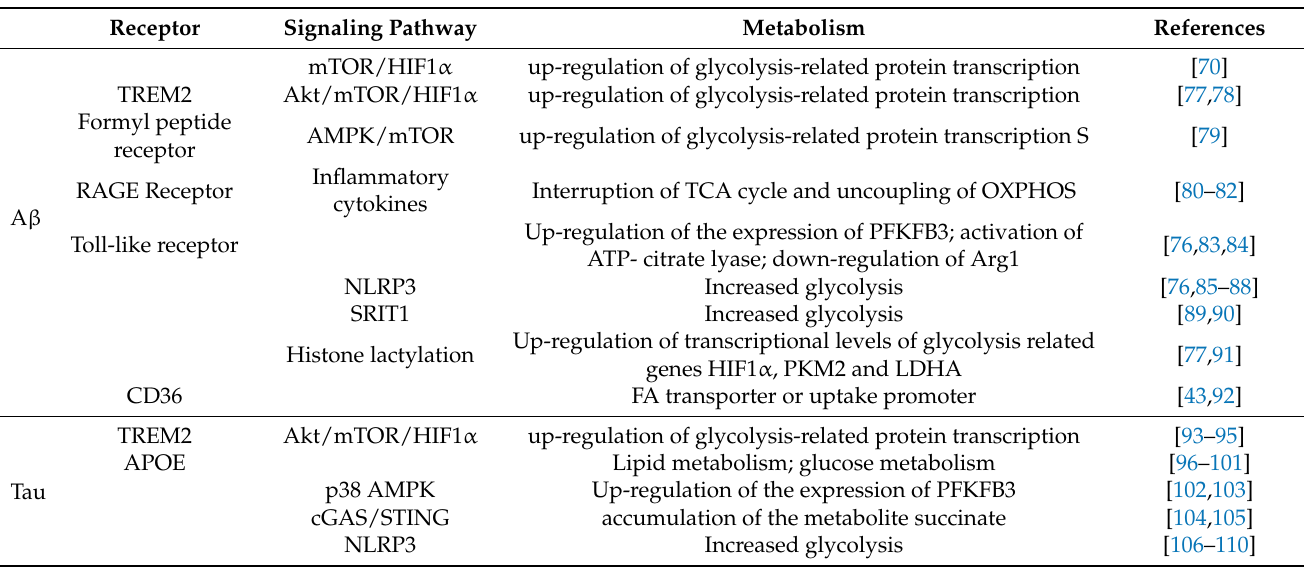
Table 1. Effect of A β oligomers and tau oligomers on microglia